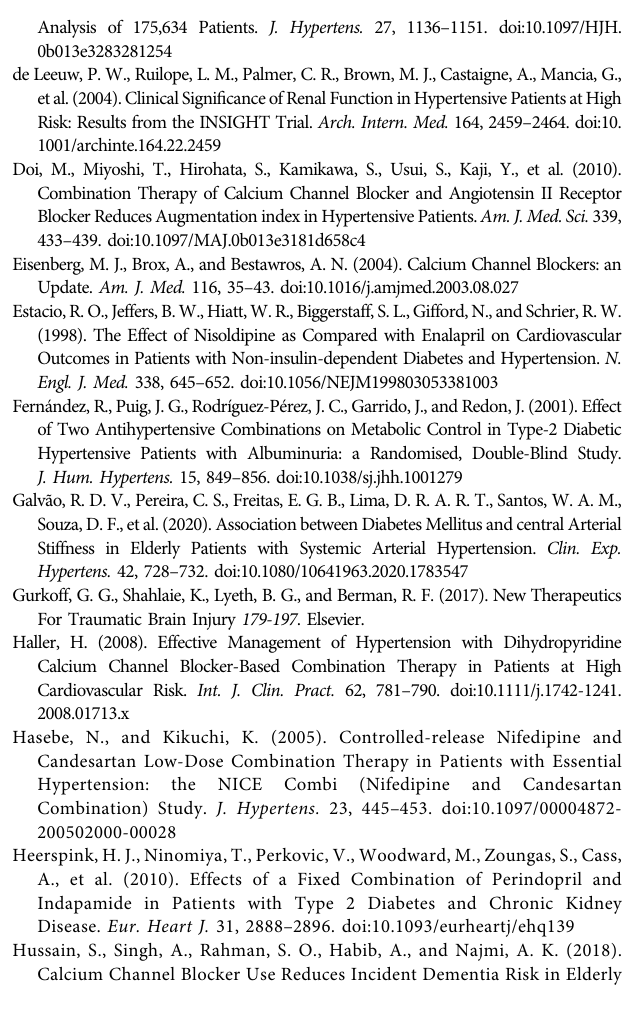
Supplementary Figure S1 | Distribution of covariates before propensity-